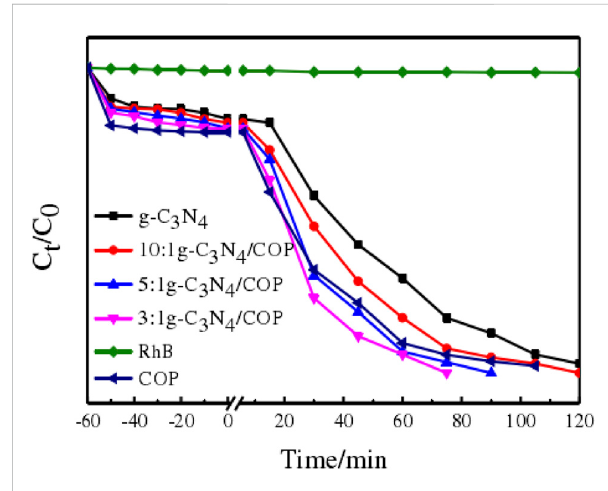
FIGURE 9 Degradation-time curves of RhB degradation by different ratios of g-C 3 N 4 /MeTMC-COP.